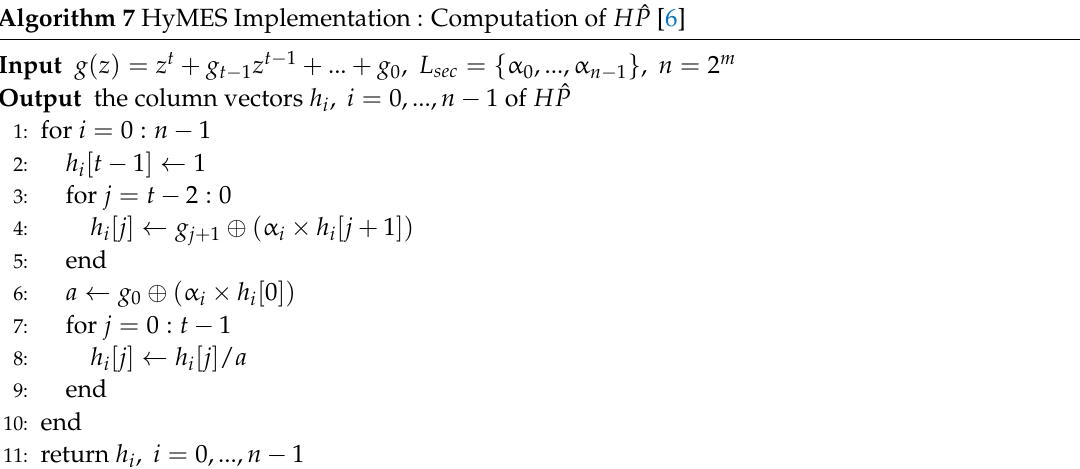
Algorithm 7 HyMES Implementation : Computation of H ˆ P